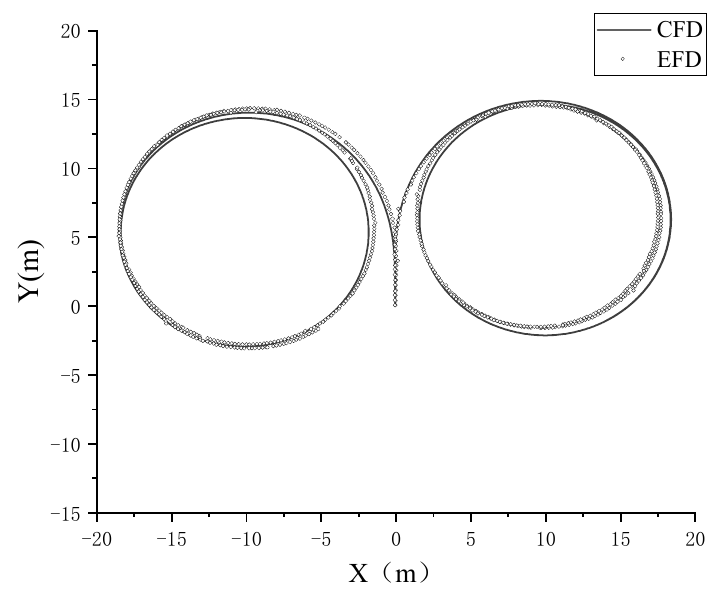
Figure 9. Comparison of circular turning trajectories. Table 6. Comparison of characteristic parameters of turning circle.